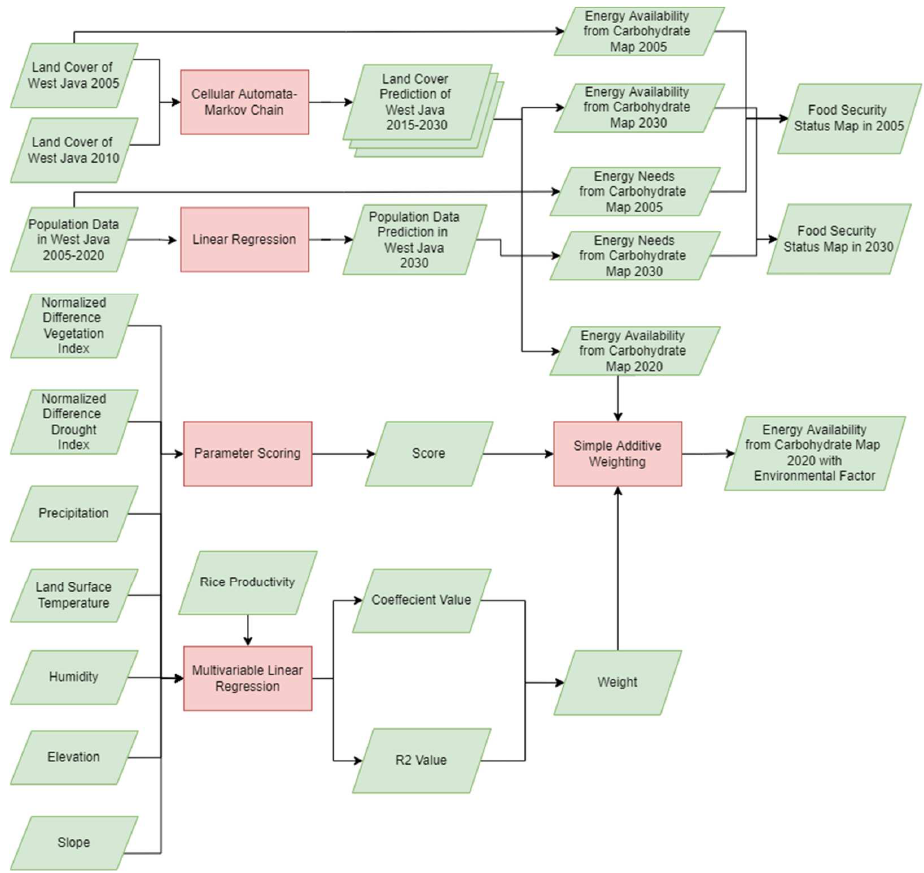
Figure 2. Flow chart of the